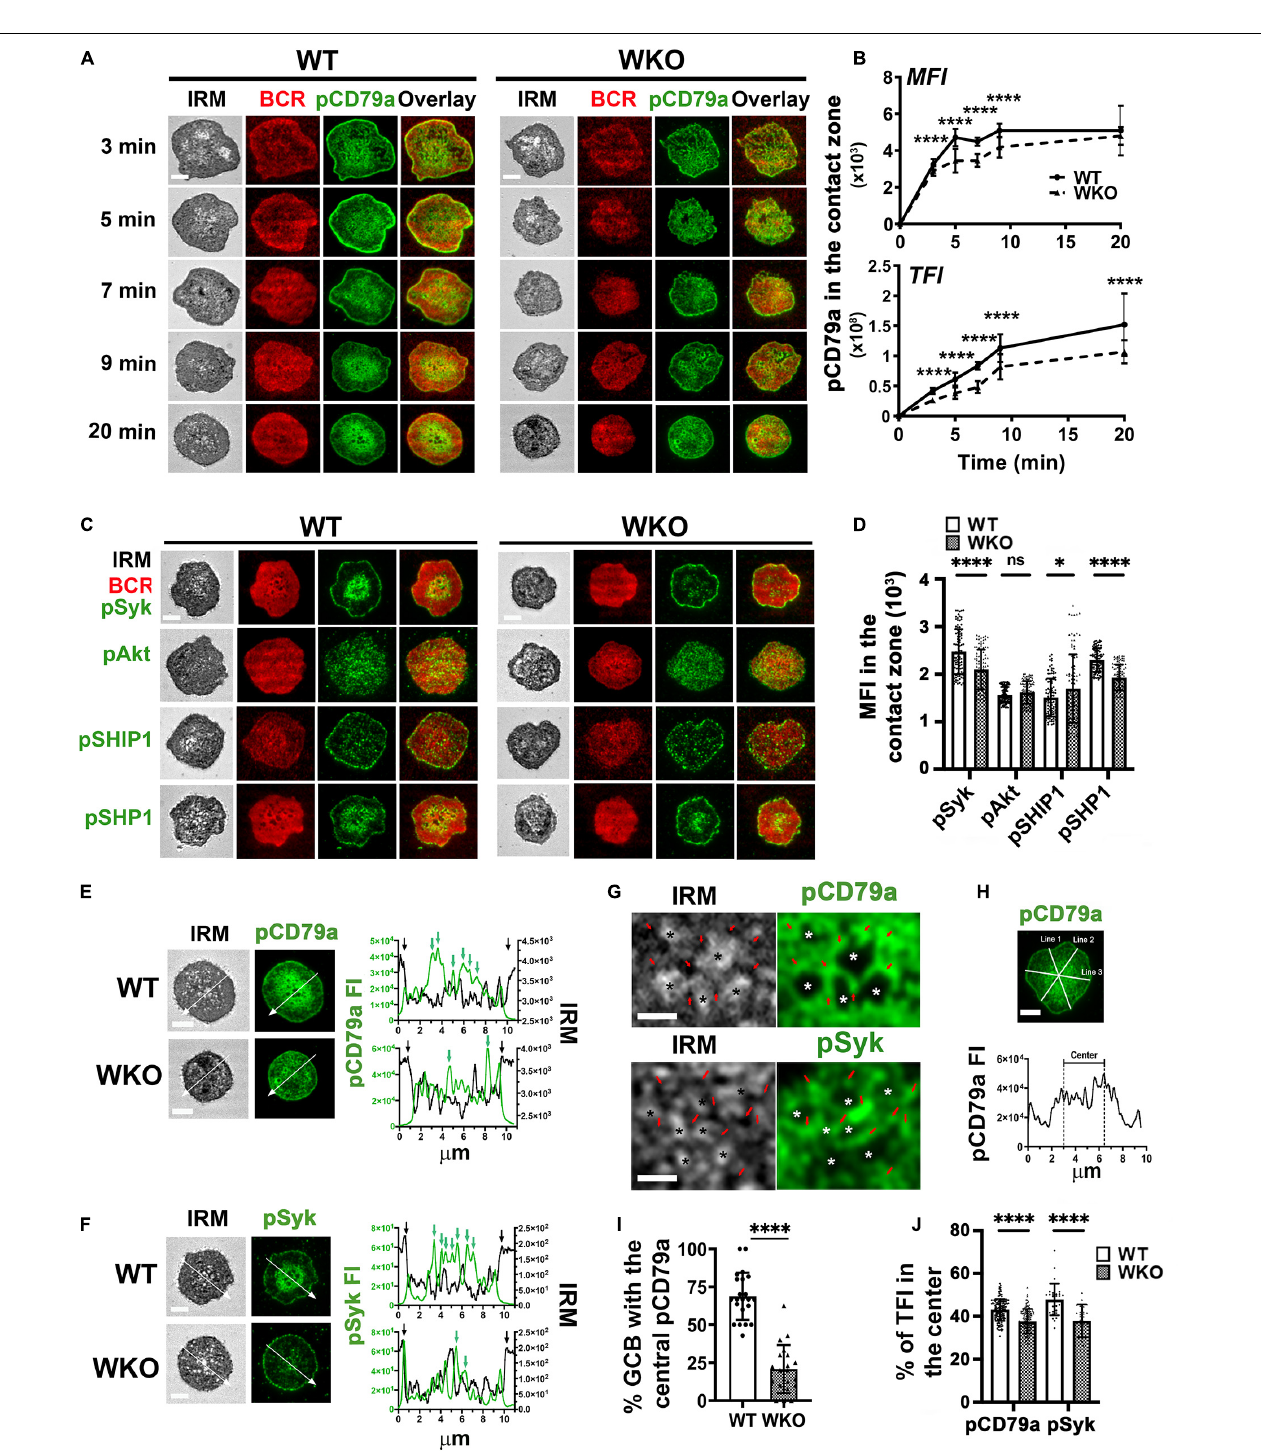
FIGURE 1 | WASp knockout (WKO) reduces BCR signaling and distorts the immunological synapse (IS) of light-zone germinal center B-cells (LZ GCBs). GCBs isolated from sheep red blood cells (SRBC)-immunized wild type (WT) and WKO mice were incubated with Alexa Fluor (AF) 546-conjugated monobiotinylated Fab’-anti-mouse IgM + G tethered planar lipid bilayers (Fab’-PLB) at 37 ◦ C and fixed at different times, permeabilized, stained for phosphorylated CD79a (pCD79a), Syk (pSyk), Akt (pAkt), SHIP1 (pSHIP1), or SHP1 (pSHP1). The GCB plasma membrane contacting Fab’-PLB (contact zone) was imaged by an interference reflection microscope (IRM) and a total internal reflection fluorescence microscope (TIRF). (A) Representative IRM and TIRF images of WT and WKO GCBs stained for pCD79a at 3, 5, 7, 9, and 20 min. (B) The mean fluorescence intensity (MFI) and the total fluorescence intensity (TFI) of the pCD79a in the contact zone